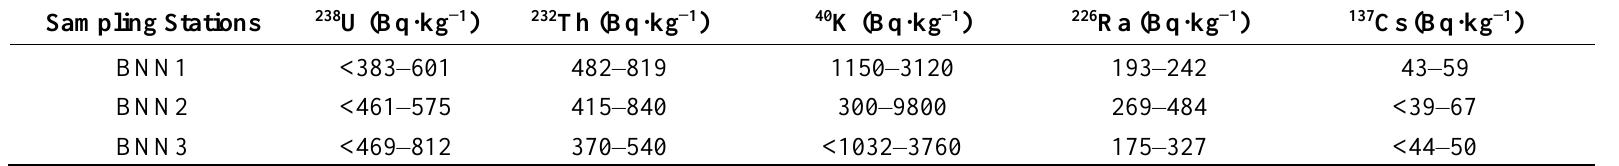
Table 2. Activity concentration ranges for radionuclides in the sediments of the Bonny estuary.